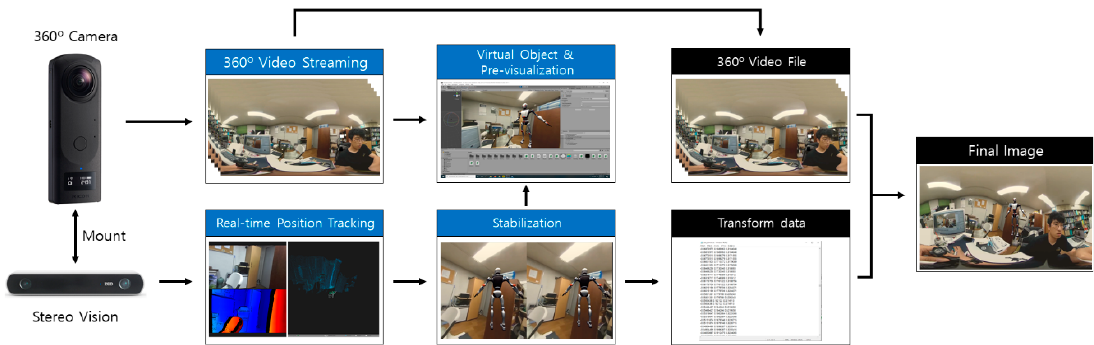
Figure 3. The proposed system workflow using stereo vision for extracting the external parameters of the 360° cameras, which were mounted together. The blue boxes show the recording step the 360 ◦ cameras, which were mounted together. The blue boxes show the recording step (production) (production) and the black boxes show the post-recording steps (post-production). and the black boxes show the post-recording steps